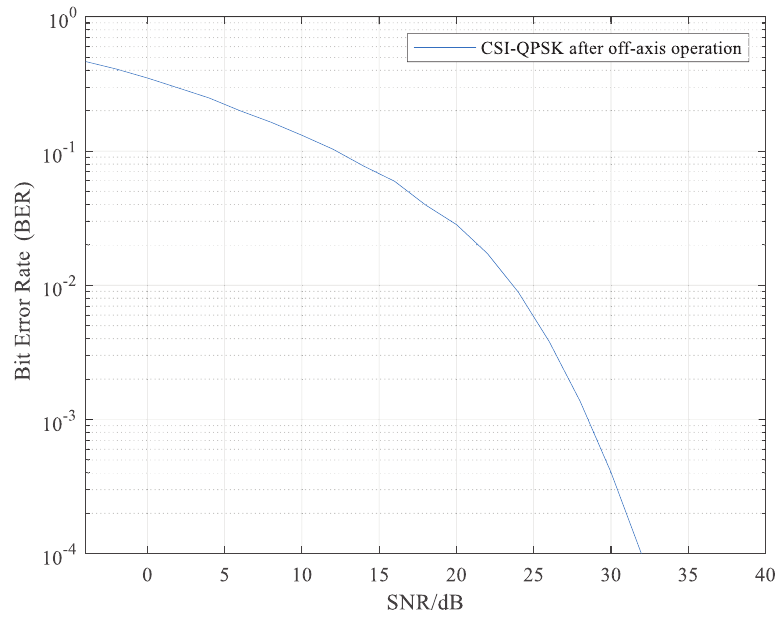
Figure 12. BER after off-axis